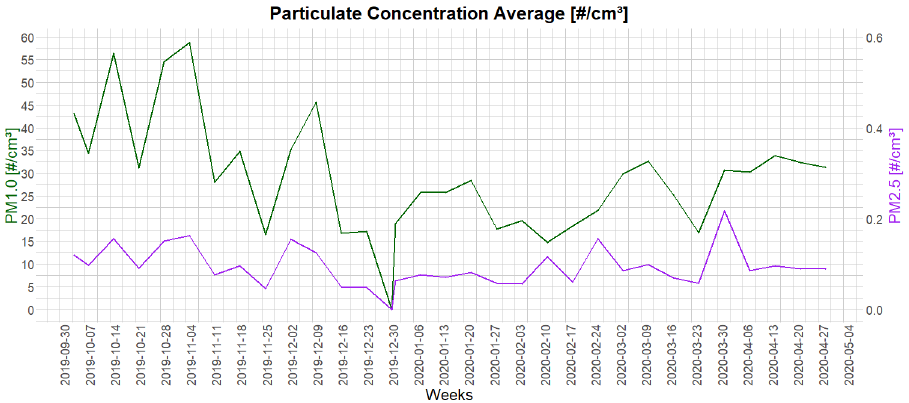
Figure 3. The weekly particle concentration averages (#/cm 3 ).